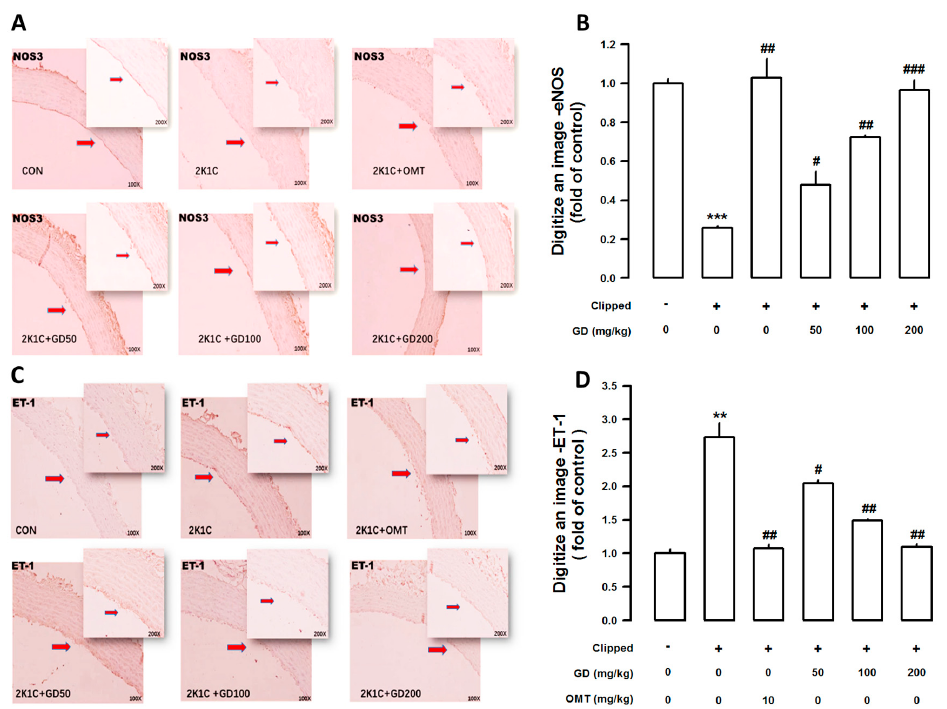
Figure 4. Effect of Gynura divaricata ( L .) DC on endothelial nitric oxide synthase (eNOS) and endothelin-1 (ET-1) expressions in the blood vessels. ( A ) Immunohistochemical expression of eNOS in the aorta (magnification × 200); ( C ) Immunohistochemical expression of ET-1 in the aorta. Quantitative analysis of eNOS ( B ) and ET-1 ( D ) area. ** p < 0.01, *** p < 0.001, vs. CONT and # p < 0.05, ## p < 0.01, ### p < 0.0001 vs.